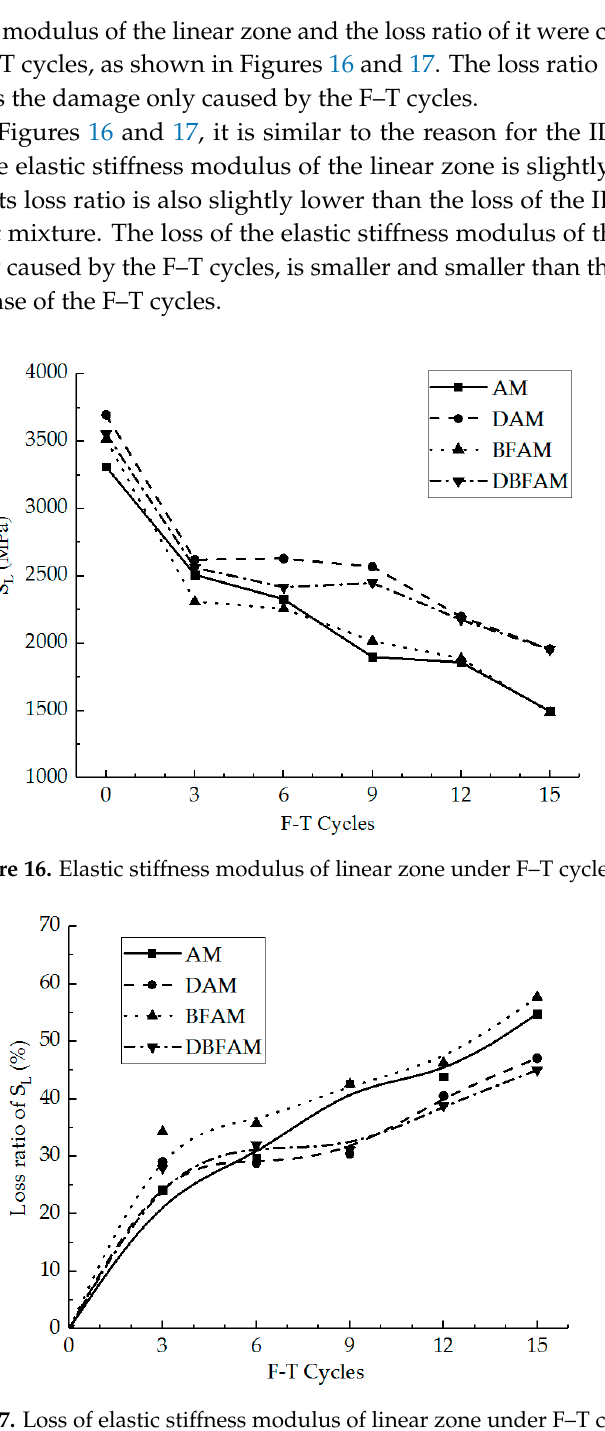
Figure 17. Loss of elastic stiffness modulus of linear zone under F–T cycles.